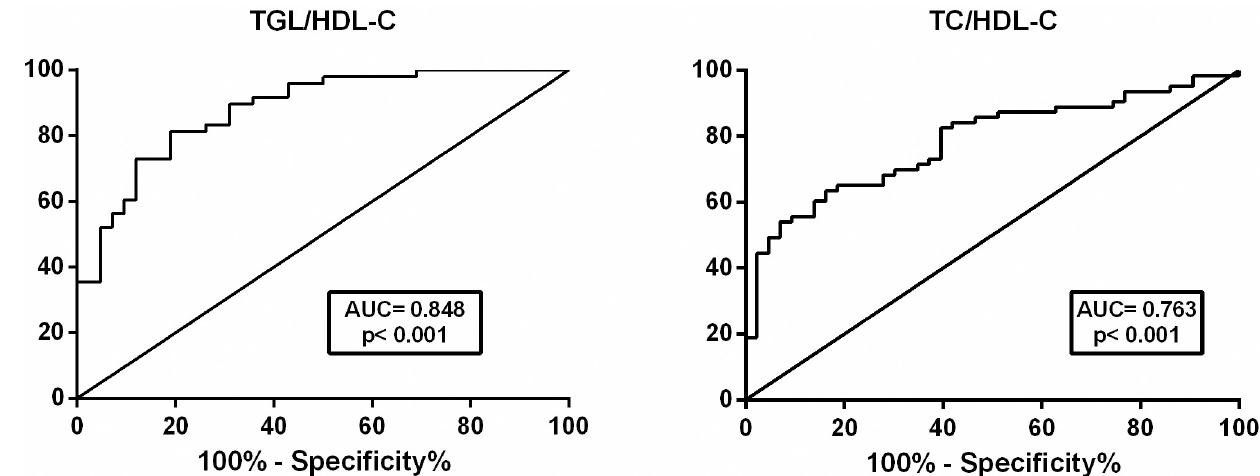
Fig 2. ROC curves for TGL/HDL-C and TC/HDL-C ratios in predicting metabolic syndrome in children with overweigh or obesity.